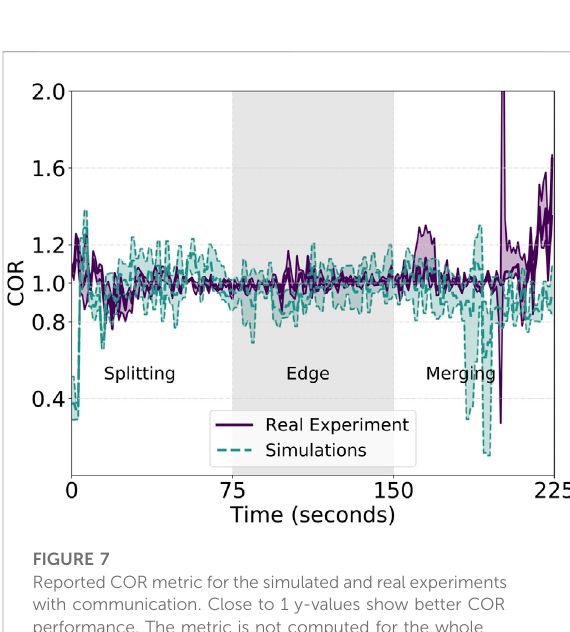
merging along it. Lines in the plot de fi ne the trajectories of different robots over each run. All the robots share the same settings and the fl ocking controller used is the same as in Eq. 1.